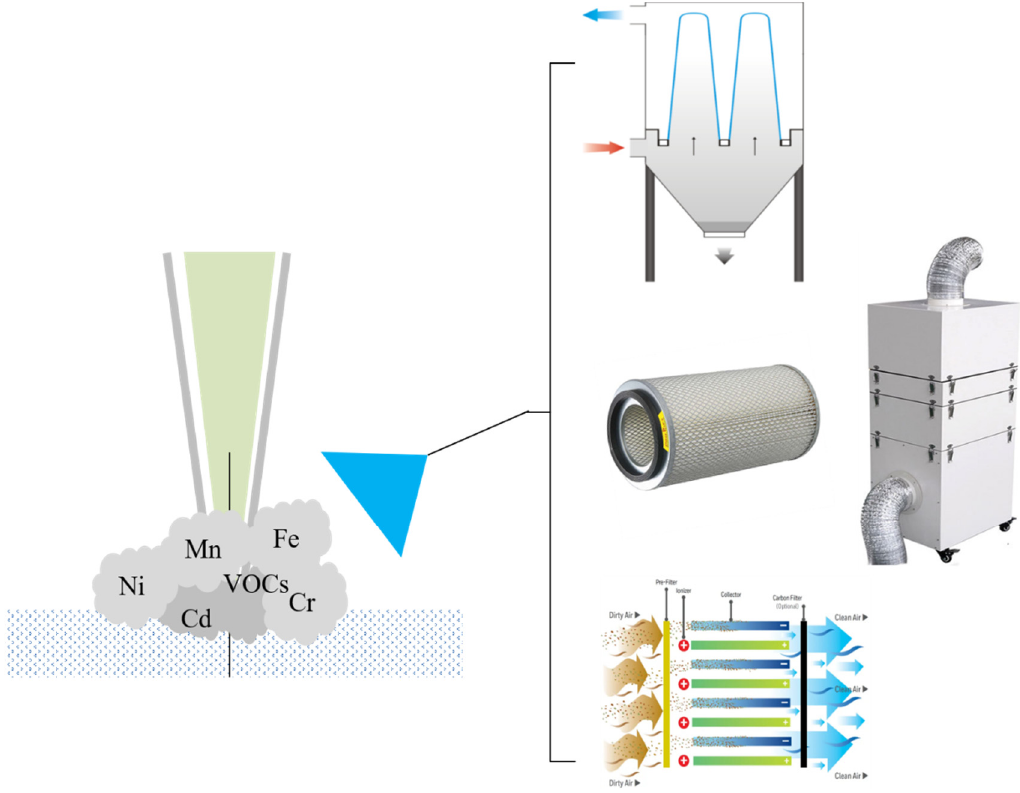
Figure 5. The pollution control strategy for laser cutting.